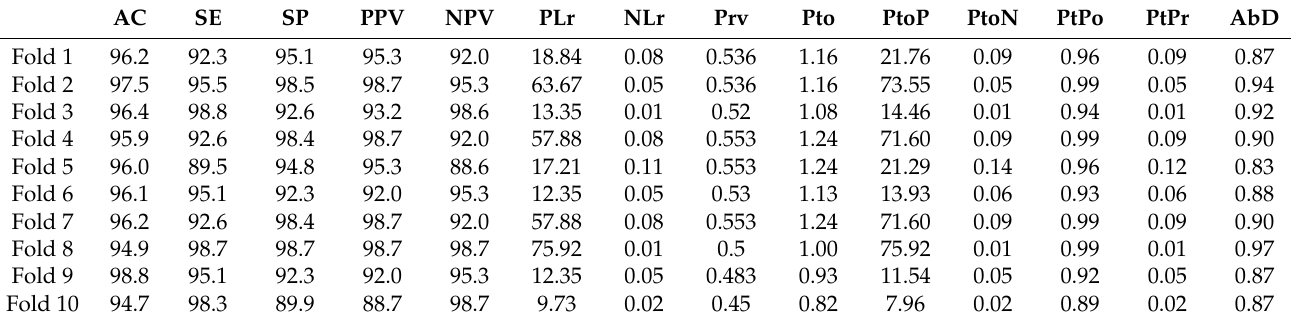
Table 8. Statistical analysis of the proposed PCAN